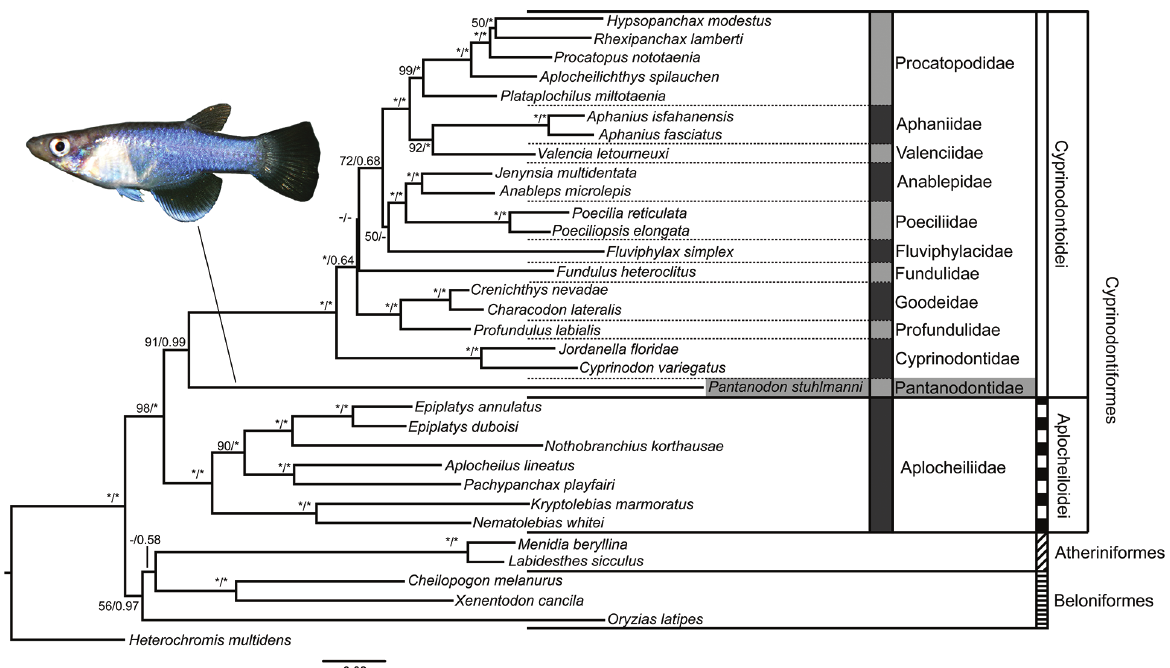
Figure 1. Phylogenetic relationship tree generated by a Maximum Likelihood Analysis of molecular data (5,083 bp, comprising seg - ments of the nuclear genes ENC1, GLYT, MYH6, SH3PX3 and RAG1 and the mitochondrial gene COI). Clade names follows the classification herein proposed. Numbers on each node are bootstrap percentages of the Maximum Likelihood analysis and posterior probabilities of the Bayesian Inference analysis; asterisks indicate maximum values (100 or 1.00 respectively) and a dash refers to values under 50 or 0.50